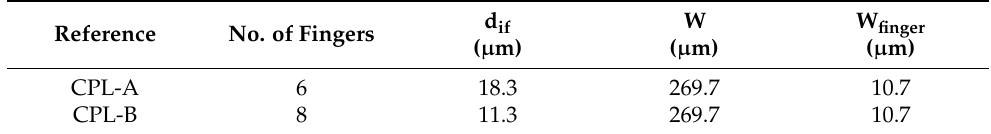
Table 1. Dimensions of the studied capacitive coupling structures.